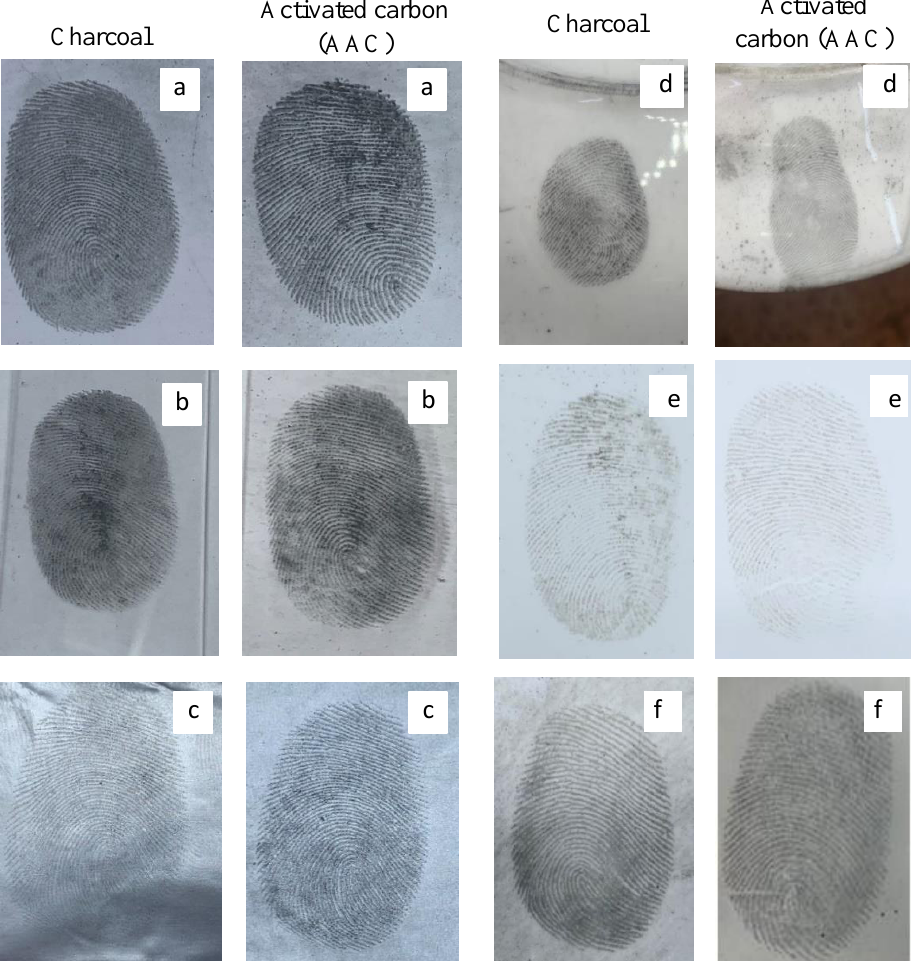
Fig. 8. Comparative visualizations of latent fingerprints between commercial charcoal and AAC on several nonporous surfaces(a) cardboard. (b) plain glass (c) aluminum foil sheet. (d) China Dish. (e) Plastic(f)